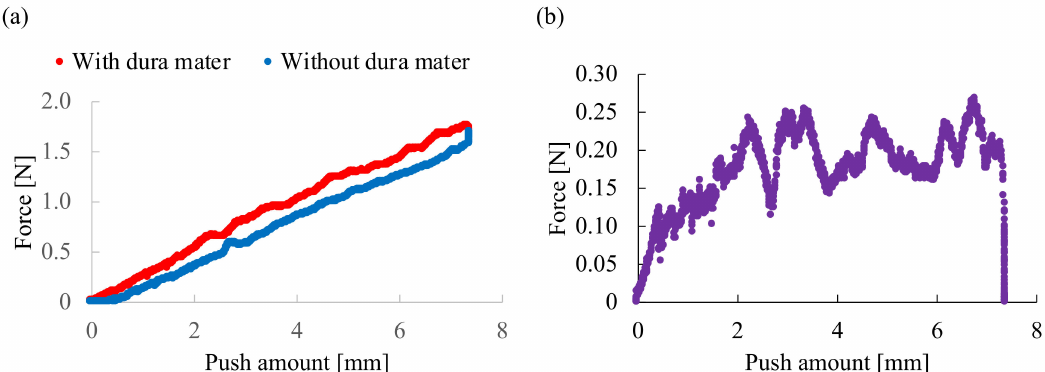
Figure 11. Results of the microscissors tests: ( a ) Measured force during the sectioning of the dura-mater (with dura-mater) and at the instant at which the microscissors just pushed through it (without dura-mater); ( b ) Cutting force di ff erence with and without dura-mater.